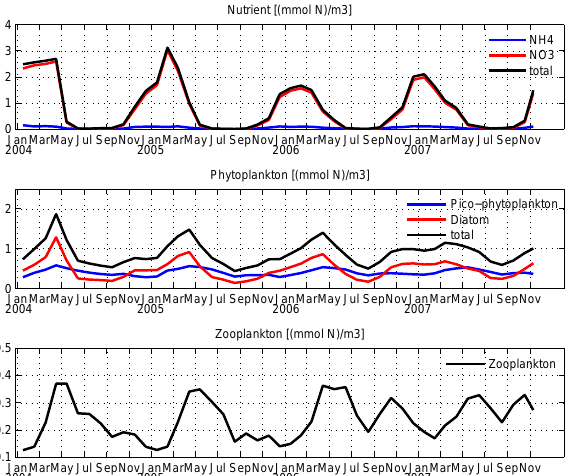
Figure 5. Monthly mean time series of nutrient, phytoplankton and zooplankton 809 Fig. 5. Monthly mean time series of nutrient, phytoplankton and components simulated by the model. 810 zooplankton components simulated by the model.